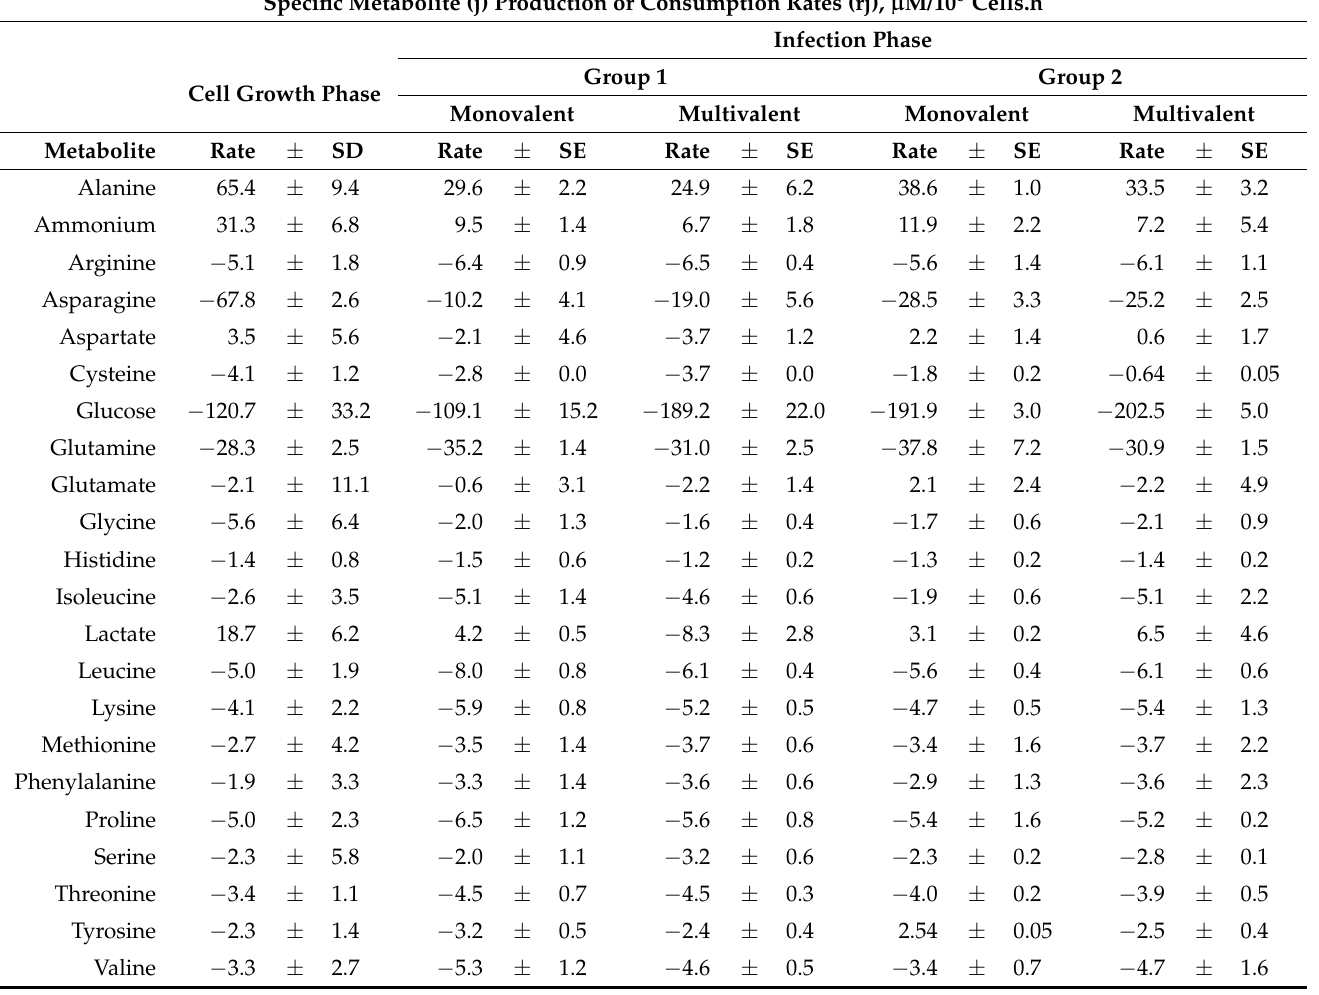
Table 2. Specific metabolite consumption and production